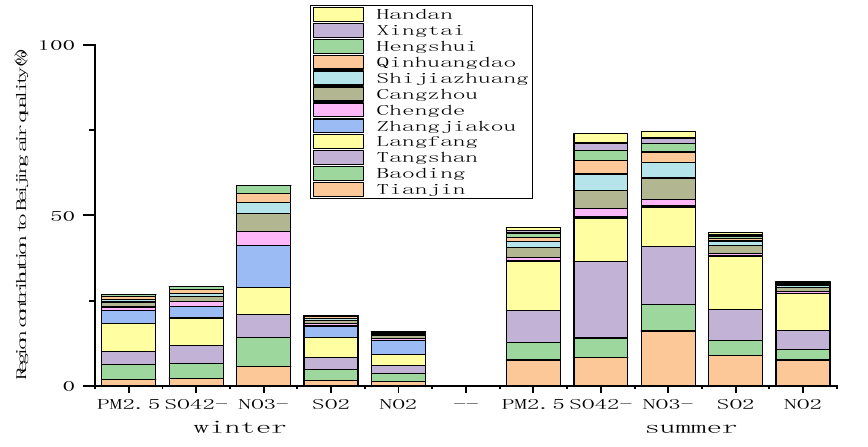
Figure 11. High-resolution source apportionment results. Table 3. Emission inventory in the Beijing–Tianjin–Baoding region (ton/year).